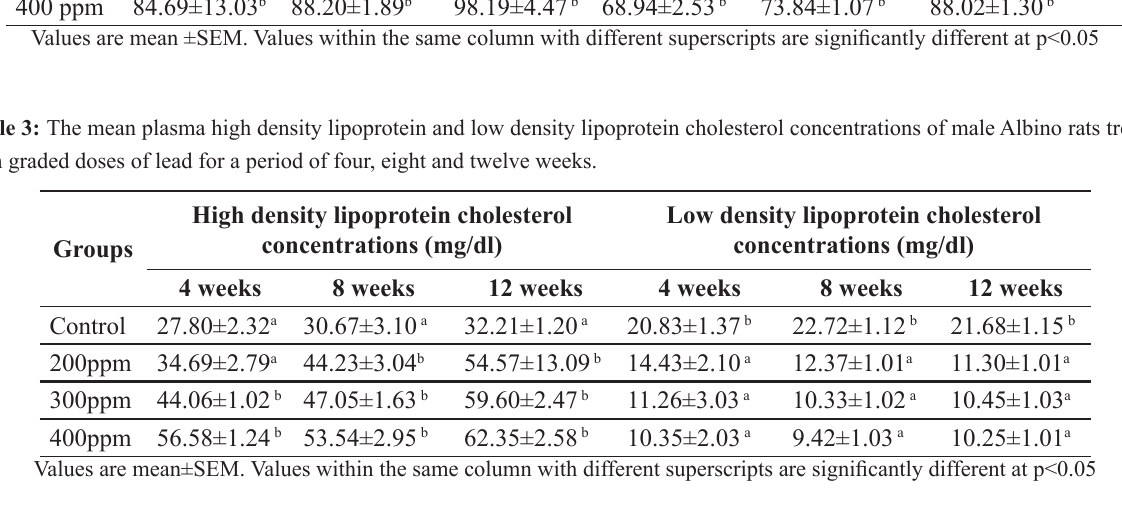
Table 4: The mean plasma phospholipid concentrations of male Albino rats treated with graded doses of lead for a period of four, eight and twelve